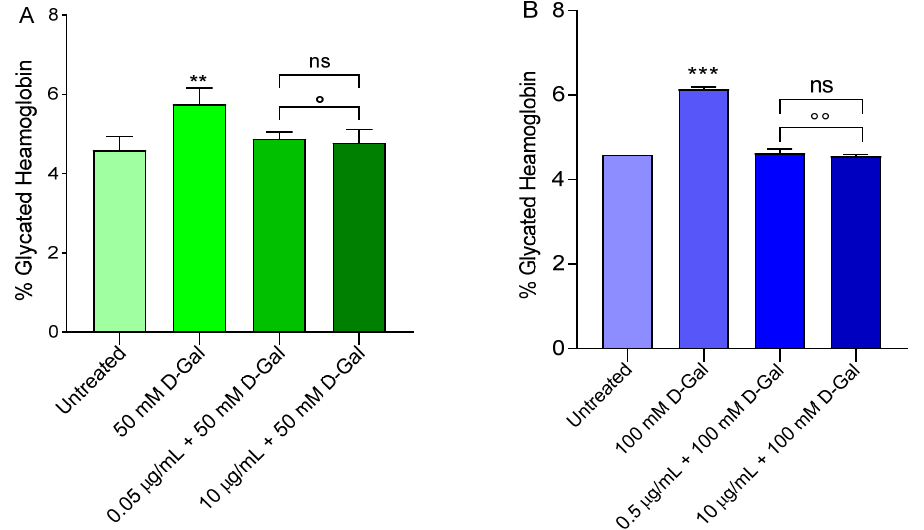
Figure 10. Glycated haemoglobin content (%A1c). Erythrocytes were left untreated or incubated for 24 h with 50 ( A ) or 100 mM ( B ) D -Gal, with or without pre-exposure to 0.5 or 10 µg/mL freeze-dried Açaì extract (pre-incubation for 1 h). ns, not statistically significant versus untreated; **, ***, p < 0.01, and p < 0.001 versus untreated (control); °, p < 0.05 versus 50 mM D -Gal; °°, p < 0.01 versus 100 mM D -Gal, one-way ANOVA with Bonferroni’s multiple comparison post-hoc test ( n = 10).